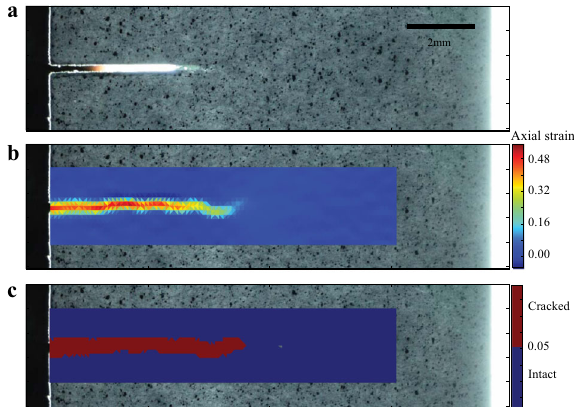
Fig. 9 Determining crack length with image analysis. Optical images and thresholded digital image correlation strain map overlaps showing extent of crack growth. It was dif fi cult to discern the crack tip in the a transmitted light optical images, but the strain maps ( b , c ) allowed for measurement of the